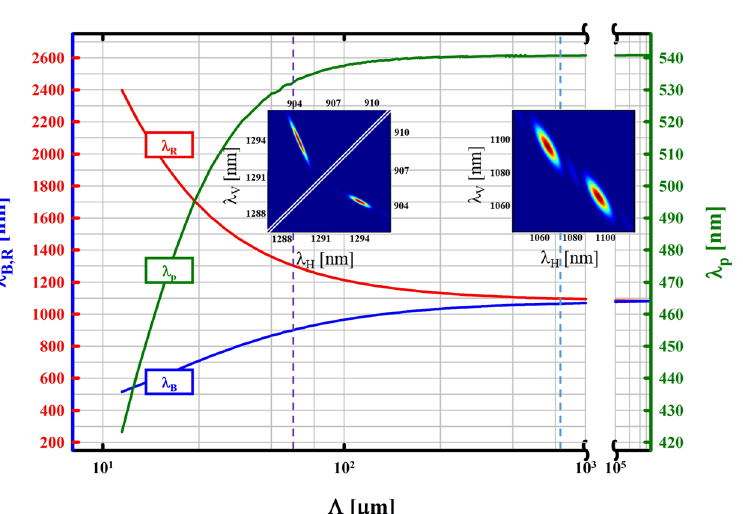
Figure 3. Possible configurations allowing for intrinsic entanglement of photons generated by CDDC in ppKTP. The blue and red lines represent the short- and longwave photons respectively (each coming in both polarisations H and V ); the green line represents the wavelength of the pump laser. The dashed purple line and corresponding inset graph highlight our specific experimental setup with λ p 0 = 532.3 nm, λ B = 904.3 nm and = 1293.9 nm. With increasing crystal periodicity Λ the wavelengths λ λ R which gives rise to the opportunity of creating entangled photon pairs with similar bandwidths and group velocities, as depicted by the right inset graph over the light blue dashed line. The calculations were performed assuming a crystal temperature of T = 50 °C. However, the actual temperature required for accurate matching of horizontal and vertical wavelength may vary due to imperfection of the used dispersion equations 27–29